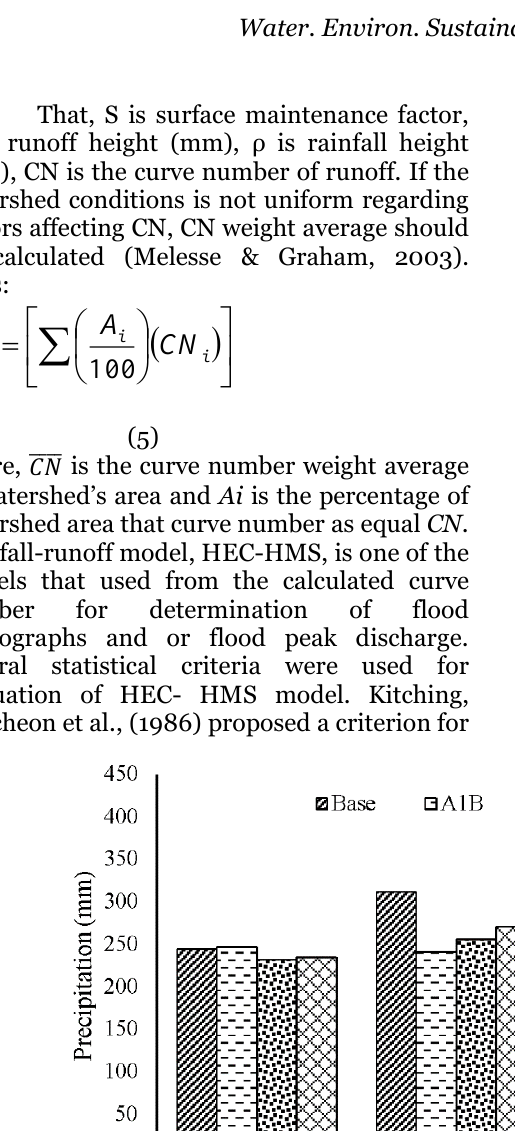
Fig.5. Mean precipitation in different scenarios of climate change